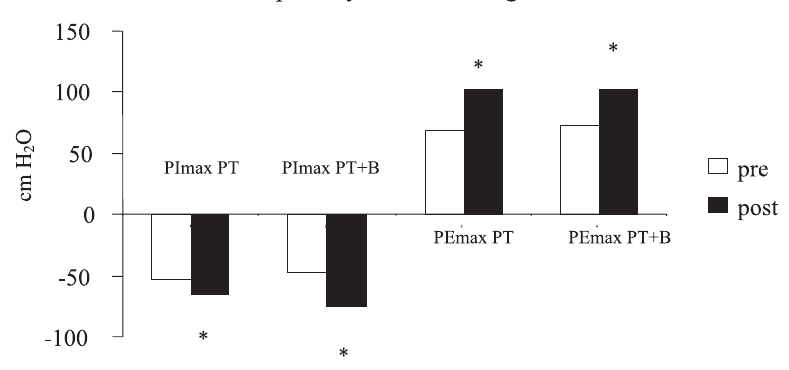
Table 3 - Results obtained at peak exercise during cardiopulmonary physical testing in the 2 groups PT PT+B PRE POST PRE POST Speed (km/h) 2.6 ± 0.9 4.1 ± 1* 2.8 ± 0.6 4.1 ± 1* Peripheral Oxygen Saturation peak (%) 85 ± 8 85 ± 8 81 ± 4 82 ± 5 Heart Rate peak (bpm) 119.4 ± 8.9 131.5 ± 17.2 110.7 ± 15.2 117 ± 10.8 Systolic Blood Pressure peak (mm Hg) 151.6 ± 22.9 152.7 ± 12.5 164.4 ± 22.9 160 ± 24.5 Diastolic Blood Pressure peak (mm Hg) 88.8 ± 16.9 88.3 ± 14.5 86.6 ± 7.0 89.4 ± 8.8 Dyspnea peak (Borg) 4.0 ± 2.1 2.5 ± 1.5 4.0 ± 1.5 3.3 ± 2.0 Lactate peak (mMol/L) 2.0 ± 1.0 2.9 ± 1.0 1.7 ± 0.7 1.8 ± 0.8 Oxygen Consumption peak (L/min) 0.8 ± 0.1 1.1 ± 0.5 0.9 ± 0.3 1.3 ± 0.3* Carbonic Gas Production peak (L/min) 0.7 ± 0.1 1.0 ± 0.5 0.9 ± 0.2 1.1 ± 0.3 *Significantly different from pretraining. P d” 0.05.